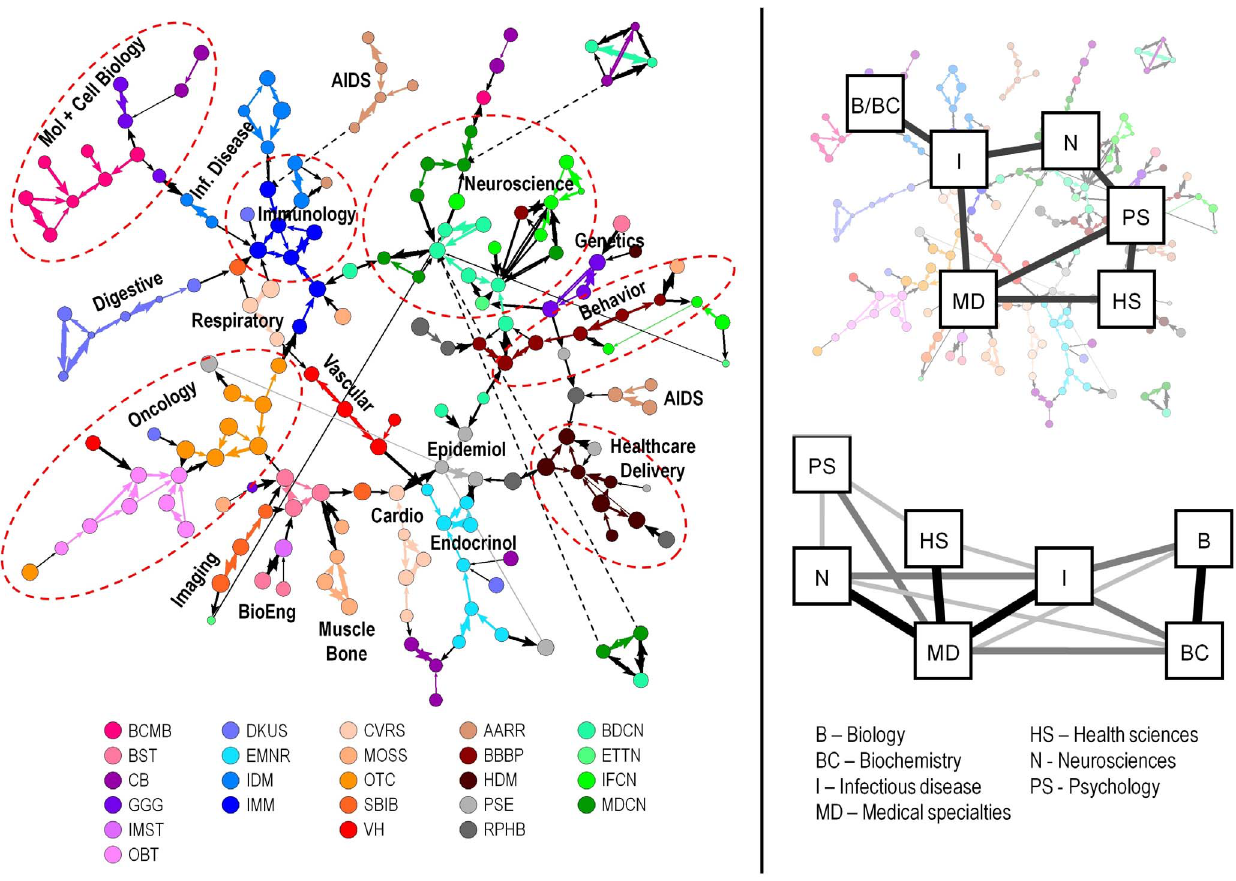
Figure 4. Left: Consensus study section network with higher order labels, which were created manually based on names of the SRGs and IRGs in different regions. This network is identical to Figure 3. Dashed ovals do not denote fixed scientific boundaries, but are intended to approximate them. Right: Comparison of the high-level structure inferred by the consensus study section network with the biomedical portion of the K/B consensus map of science. Discipline names are noted.